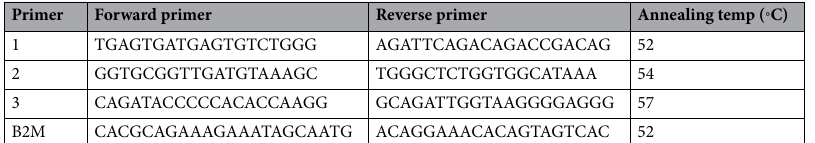
Primer Forward primer Reverse